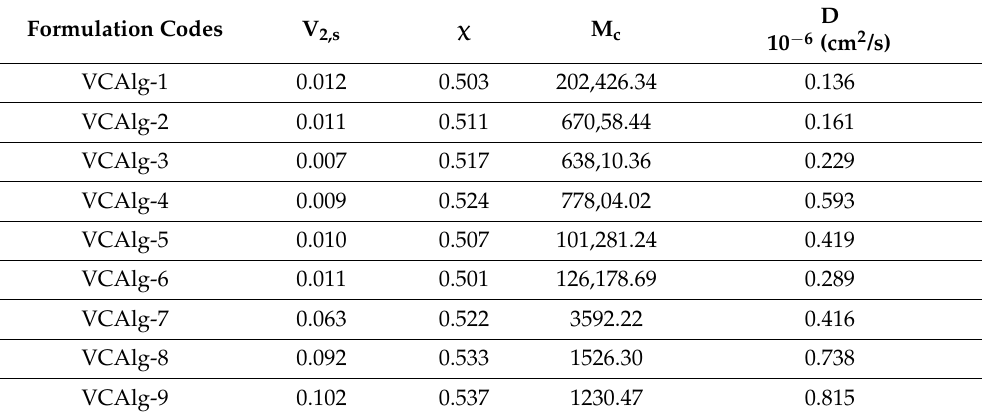
Table 3. Networking parameters of chemically grafted thermoresponsive Poly (VCL-g-NaAlg) in situ depot